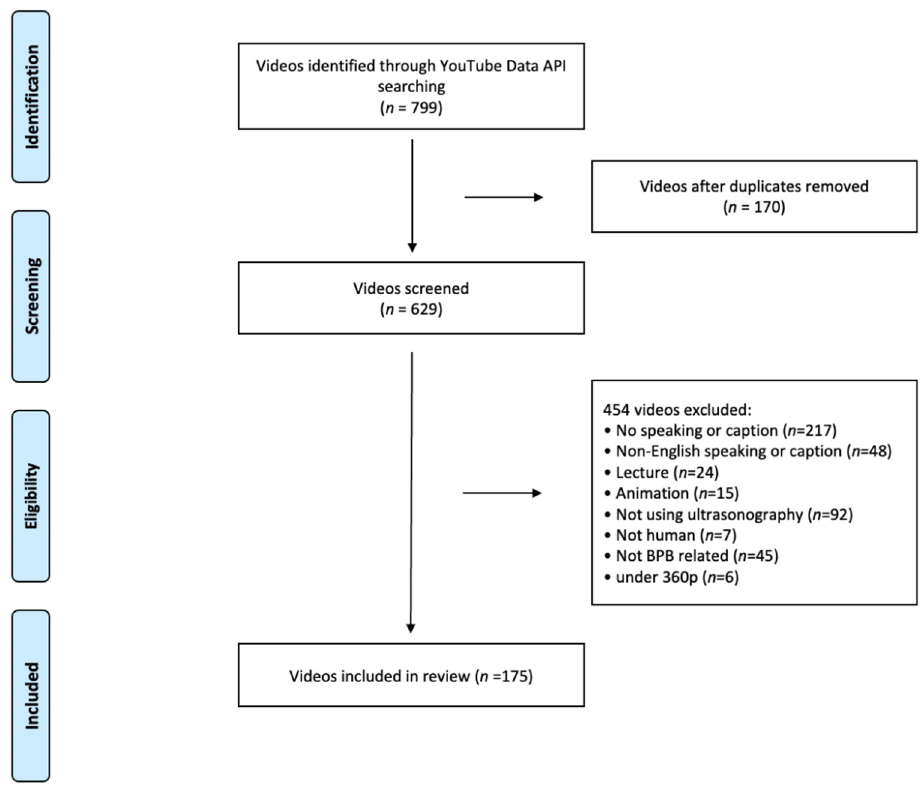
Figure 1. Flowchart of the video search and screening process: video metrics, reliability, overall quality, and specific quality of videos by source.